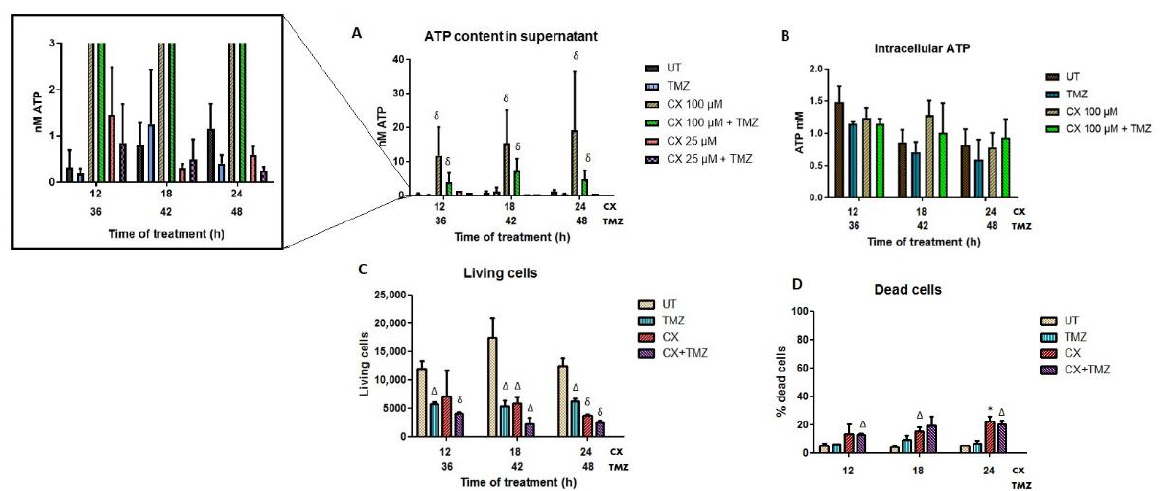
Figure 4. ATP quantification in GL261 treated cells (supernatant release and intracellular content), as well as cell viability assessment after treatment. CX-4945 (CX, 100 and 25 µ M), TMZ (2 mM), and combined CX-4945+TMZ treatments were evaluated. ( A ) ATP content released in the cell culture supernatant. Average ± SD values are shown for n = 3–6 in every condition. δ indicates p < 0.001 according to ANOVA (Tukey’s post-hoc comparisons) vs. TMZ and untreated cells. No significant differences were found between single CX-4945 and joint CX-4945+TMZ treatments. An expansion is shown on the left to appreciate values with small values better (higher values will be out of scale) ( B ) Content of intracellular ATP in GL261 treated cells after treatment, (n = 3). Average ± SD is shown, with no significant differences found. ( C ) Living cells after CX (100 µ M), TMZ (2 mM), and combined treatment CX+TMZ (100 µ M and 2 mM), analyzed by flow cytometry after PI staining, (n = 3 for each condition). ( D ) Percentage of dead cells after treatments. Average ± SD is shown for all cases. *, ∆ and δ indicate significance ( p < 0.05, p < 0.01 and p < 0.001, respectively) according to Student’s t -test, for comparisons between treated and untreated cells.